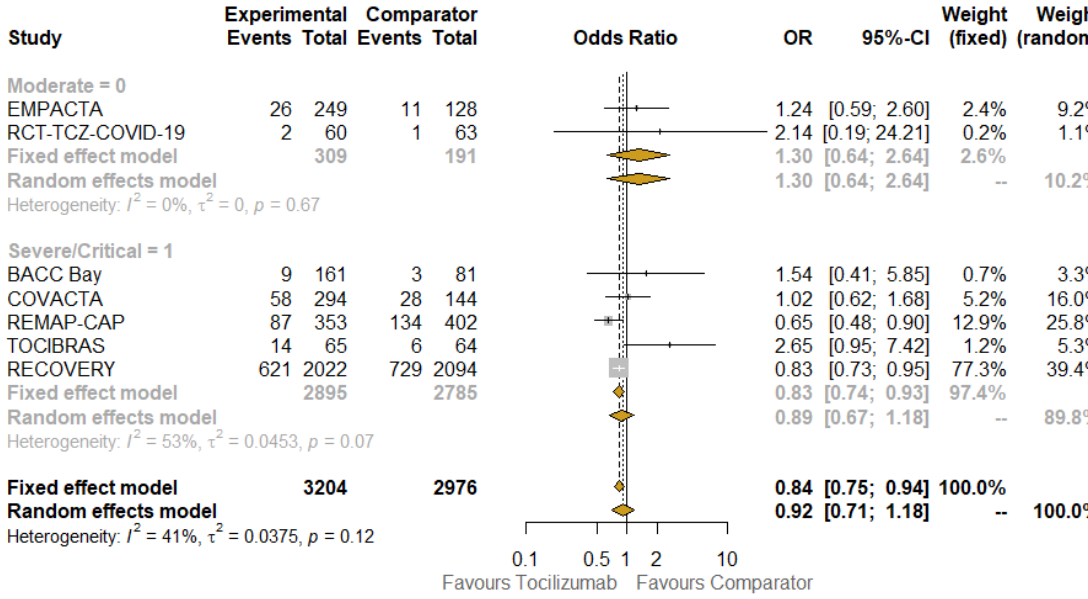
Figure 5. Pooled comparison of 28-day mortality according to disease status at baseline. Abbreviations: Soc: standard of care; OR: odds ratio; 95%-CI, confidence intervals at 95%; Weight (fixed), weight of each study in a fixed-effect model; Weight (random), weight of each study in a random-effect model. Squares on the hazard ratio plot are proportional to the weight of each study; weighting is based on the inverse variance method.